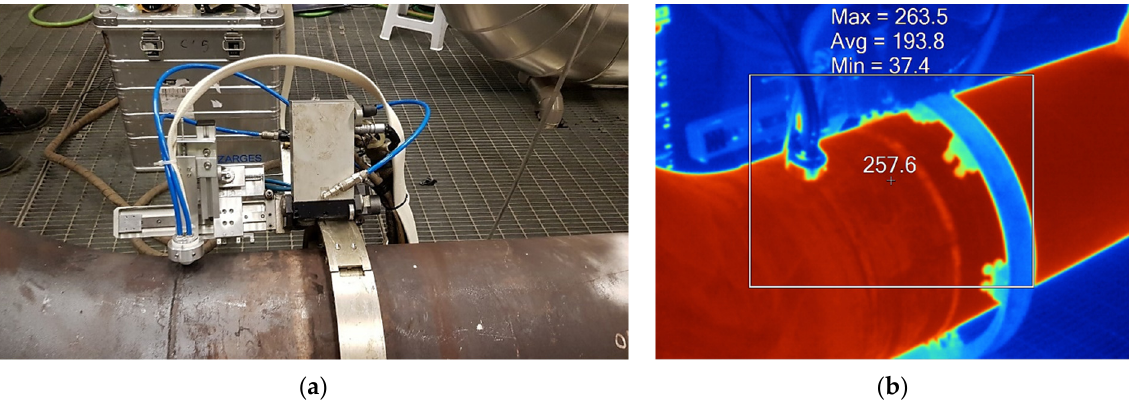
Figure 2. ECT system Validation: ( a ) automated inspection system coupled with ECT probes while performing a scan along the pipe perimeter; ( b ) thermographic image with temperature represented in degrees Celsius (°C).